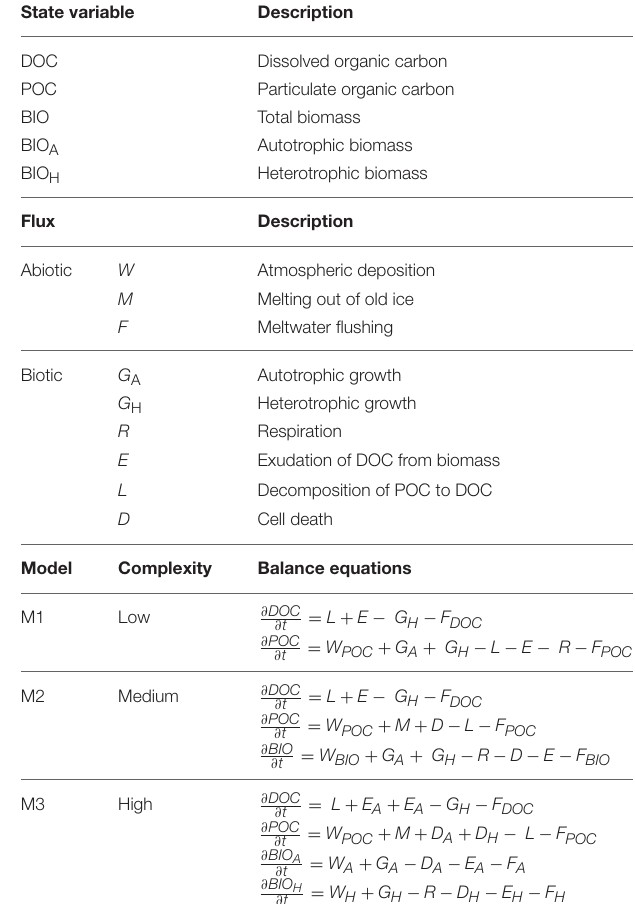
TABLE 1 | State variables, fluxes, and formulation of the supraglacial ecosystem models presented in Figure 1